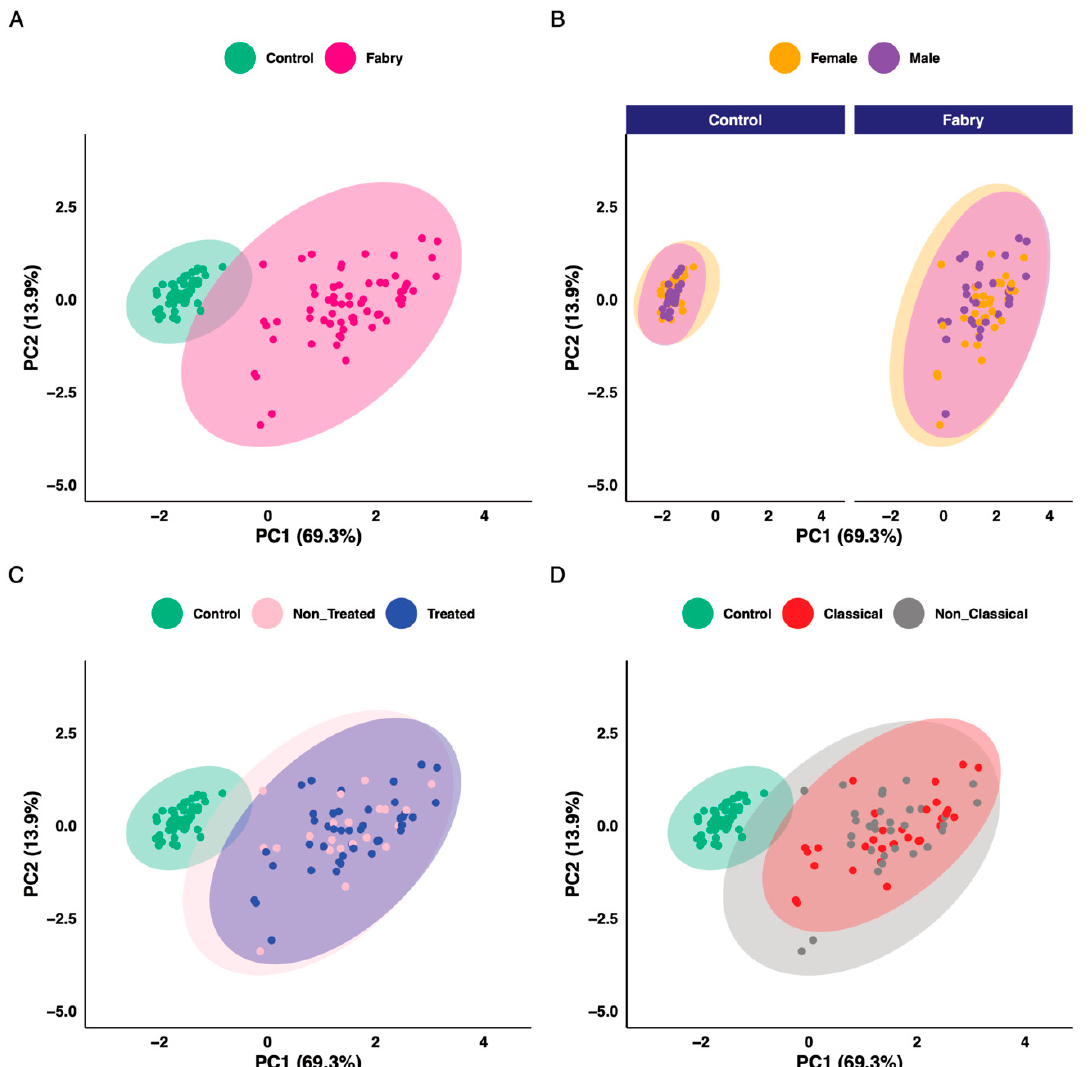
Figure 2. Principal component analysis scores plot. ( A ) Colored according to disease status. ( B ) Colored according to sex. ( C ) Colored according to treatment status. ( D ) Colored according to phenotype status.